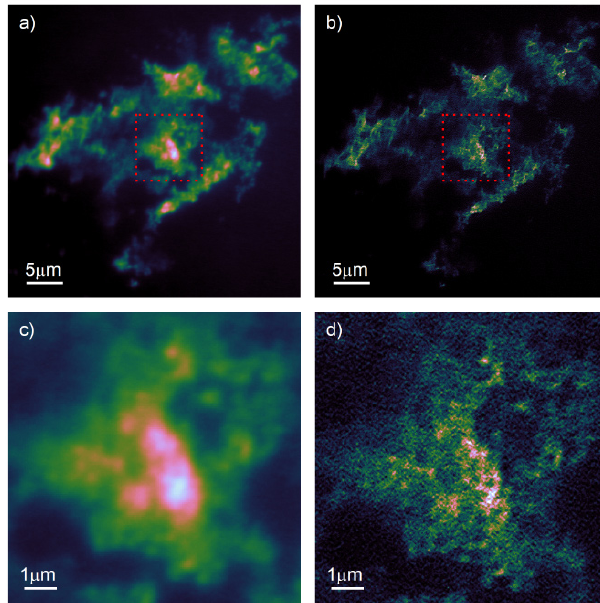
Figure 2. Fluorescence imaging of 40nm and 100nm nanodiamond on coverslip. a ) Drift corrected and summed stack of 200 individual frames. b ) Super-resolution radial fluctuations (SRRF)-processed image of same stack of images. c ), d ) zoom on equivalent region marked by red dashed box in a ), b ) showing increased resolution enabled by